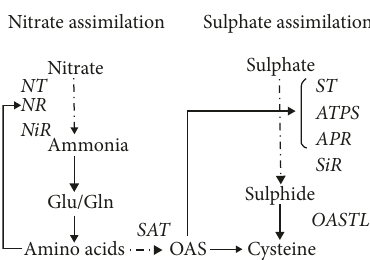
Figure 1: Scheme of assimilation of nitrates and sulphates and a combination of these processes by O -acetylserine (OAS) [72, 73]. NT, nitrate transporter; NR, nitrate reductase; NiR, nitrite re- ductase; Glu/Gln, glutamic acid, glutamine; ST, sulphate trans- porter; ATPS, ATP sulphurylase; APR, APS reductase; SiR, sulphite reductase; OASTIL, O -acetylserine(thiol)lyase; SAT, serine ace- tyltransferase; OAS, O